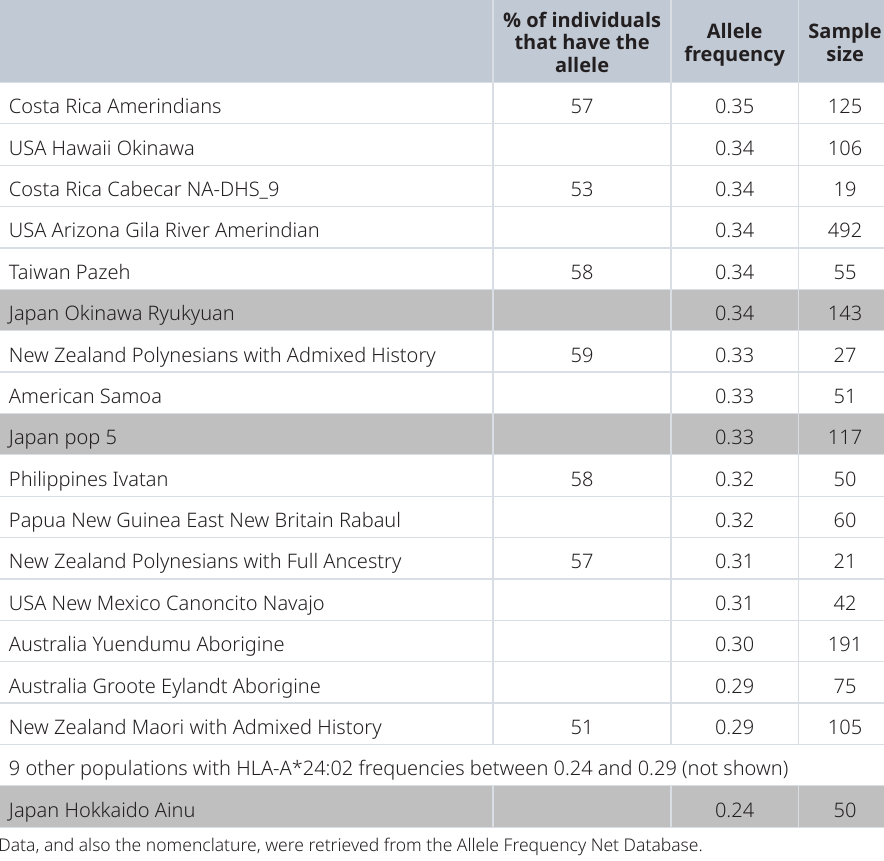
articles on SARS-CoV-1, and from reports uniquely depos- ited to the Immune Epitope Database and Analysis Resource peptides listed in Table 2 are referred to in Table 1 by using the letter code of their N-terminal three amino acids. The only identical T cell epitope repeatedly found to be immu- nogenic by independent research groups was peptide “VYI” Table 2). The VYI peptide is shared between SARS-CoV-2, HCoV-HKU1, and HCoV-OC43 viruses and part of a larger identical stretch AKHYVYIGDPAQLPAPR in their helicase protein (aka nonstructural protein 13 or NSP13). Prachar et al. (2020) showed that the VYI peptide bound to HLA-A*24:02, although not very stable. To our knowledge, all studies that investigated the VYI peptide—three in total—found it to stimulate T cells in an HLA-A*24:02 context (Ferretti et al.